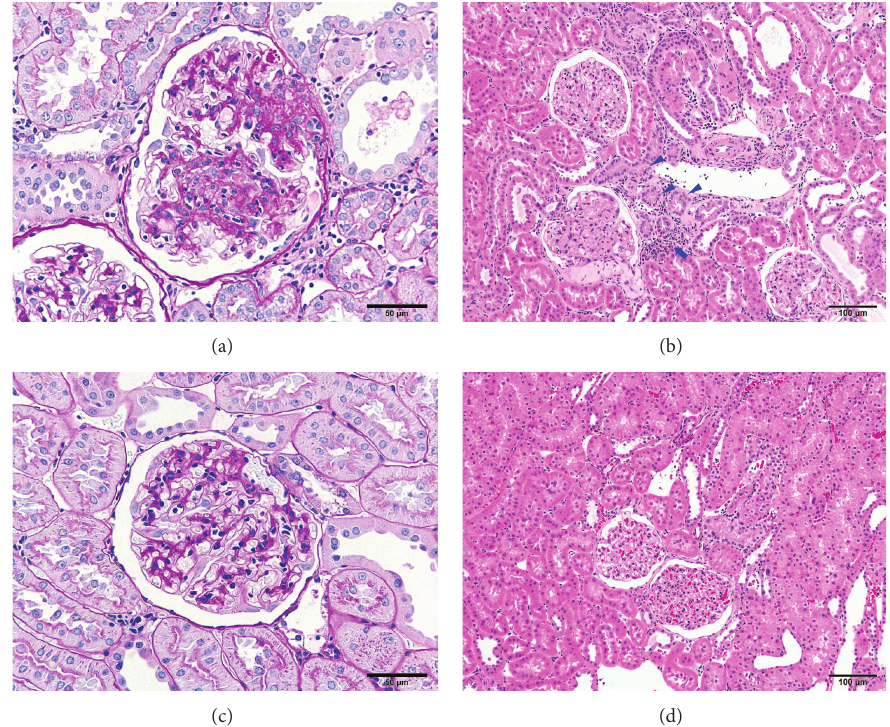
Figure 3: Photomicrograph of kidney tissues from the 1/2 Nx group (a) and (b) and sham group (c) and (d). Marked glomerulosclerosis (a) tubular regeneration (arrowhead in (b)) and inflammatory cell infiltration (arrow in (b)) observed in the 1/2 Nx group. Periodic acid Schiff ((a) and (c)), bar = 50 𝜇 m. Hematoxylin and eosin ((b) and (d)). Bar = 100 𝜇